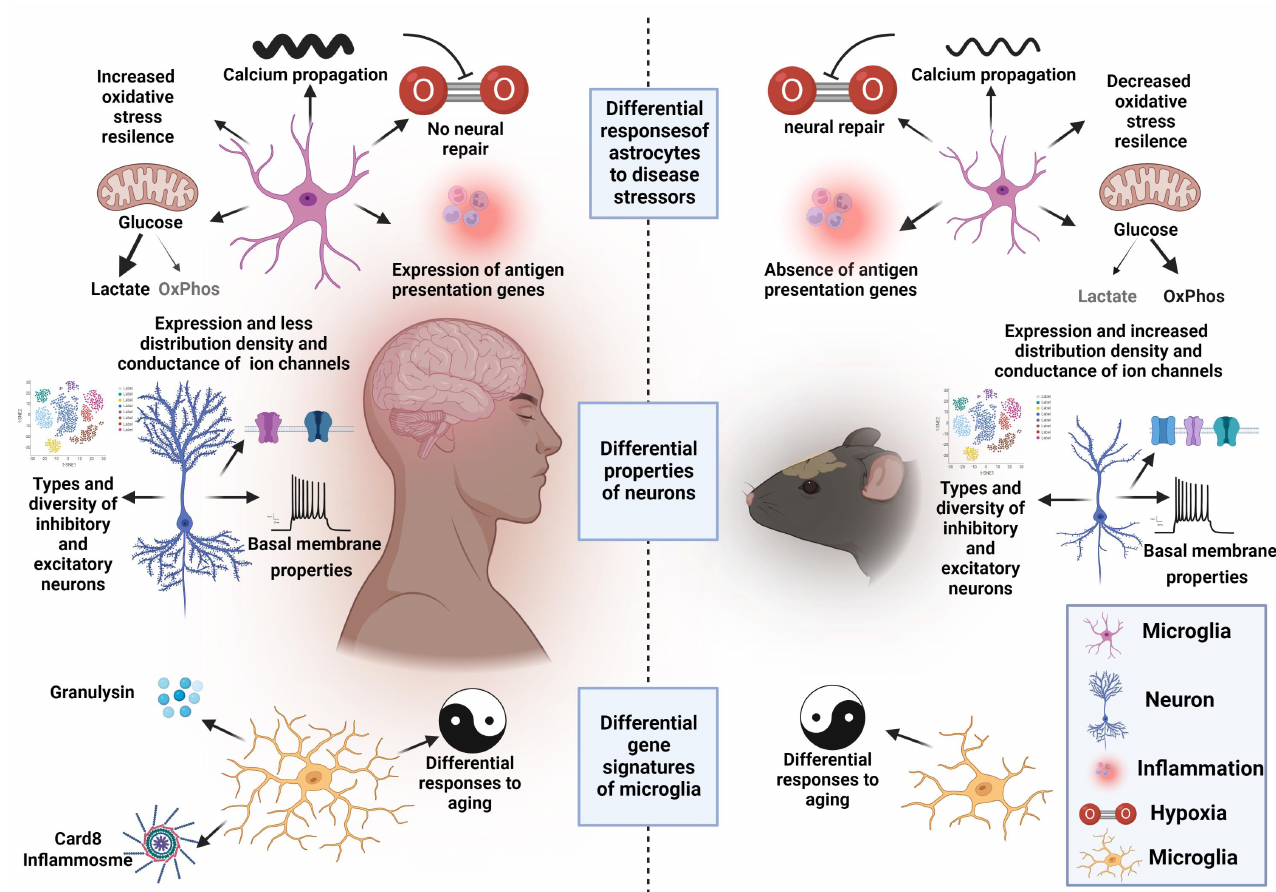
Figure 3. Species-specific differences in the intrinsic properties of astrocytes, neurons, and microglia. Apart from being larger in diameter and exhibiting extensive primary processes, hominid astrocytes display more resistance to oxidative stress, increased velocity of calcium propulsion, absence of enrichment in hypoxia-induced transcriptomic signatures of neural repair, inflammation-induced expression of antigen presentation genes, and resting state metabolism of mitochondria. Hominid features of morphologically complex, diverse, and larger neurons exhibit differential basal membrane properties, fewer channels, and lower ionic conductance per volume compared to rodent counterparts. Human microglia express some intrinsic gene signatures (not present in rodent microglia) such as the presence of CARD8, an inflammasome component; and granulysin, which is present in cytokine granules. Additionally, the ageing-related genes are oppositely misregulated in a species-dependent manner. Created with